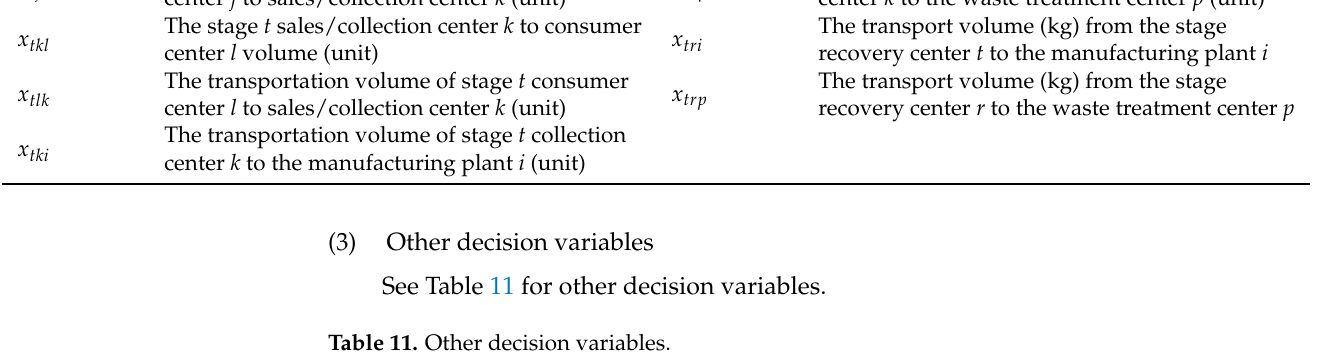
Table 11. Other decision